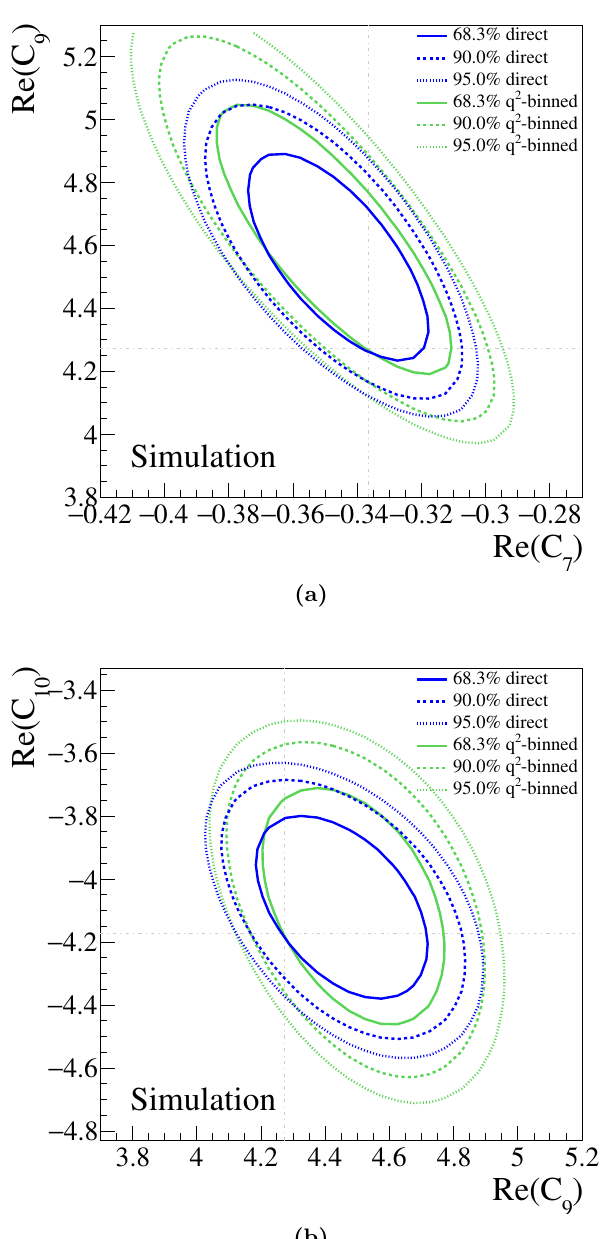
Figure 6. Con(cid:12)dence regions for (a) Re( C 7 ) and Re( C 9 ) and (b) Re( C 9 ) and Re( C 10 ) for a single pseudoexperiment. The results from the direct (cid:12)t method are given by the blue contours, the results from the determination using q 2 -binned angular observables are given by the green contours. The contours correspond to con(cid:12)dence levels of 68 : 3%, 90% and 95% for the solid, dashed and dotted lines, respectively. The SM values for the Wilson coe(cid:14)cients used in the generation are indicated by the grey dash-dotted lines.